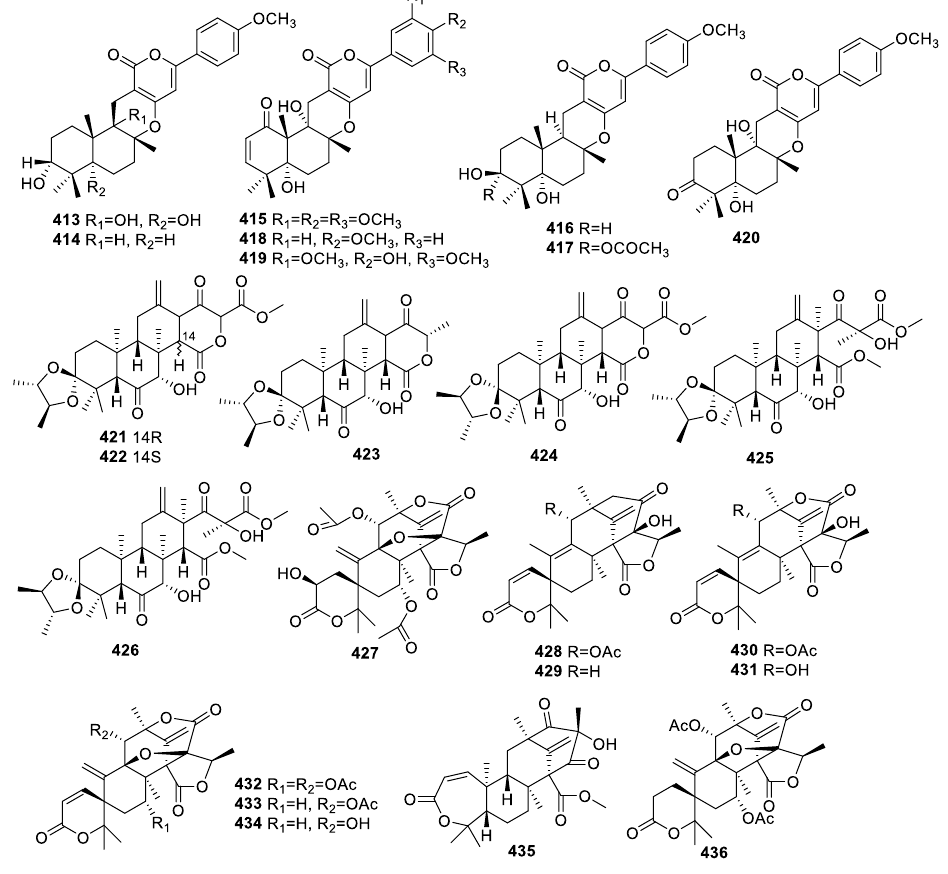
Figure 16. Chemical structures of meroterpenoids ( 413 – 436 ).